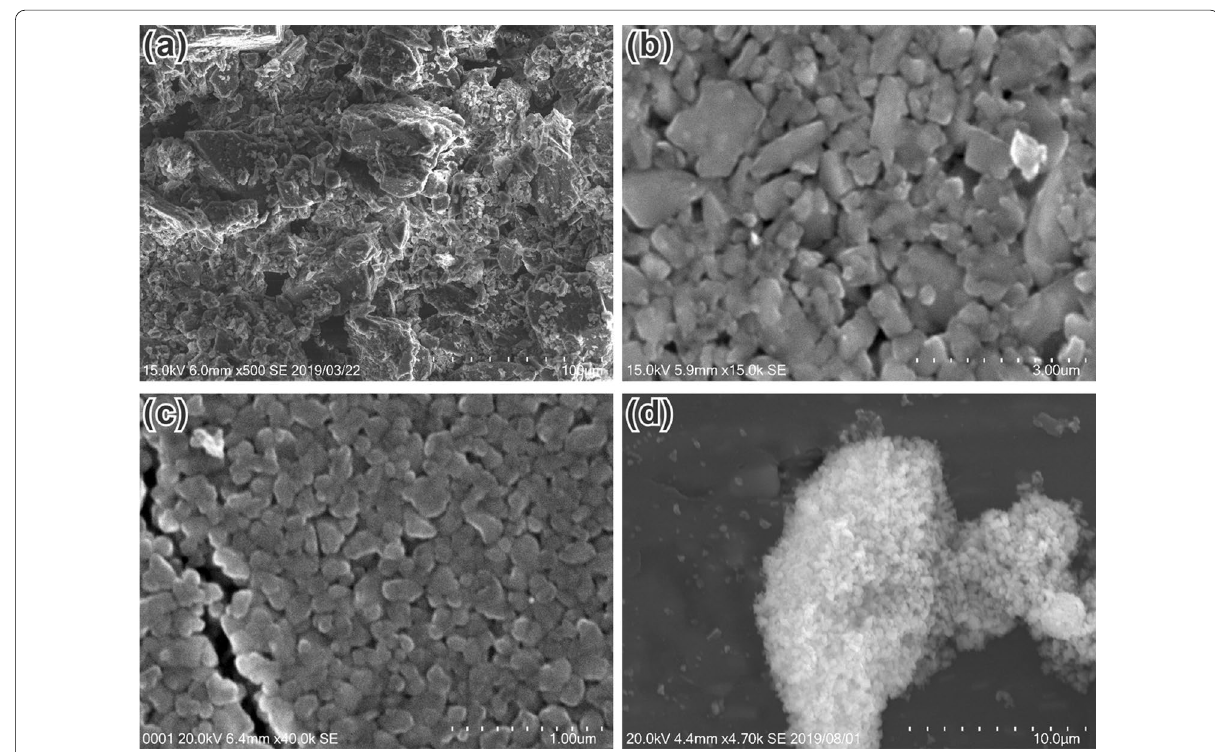
Fig. 2 SEM images of powders. a Raw albite powder before pulverisation. b Powder after pulverisation and 6 h of decantation. c Powder after pulverisation and 24 h of decantation. d Example of an agglomerated secondary particle formed after freeze‑drying under CAS